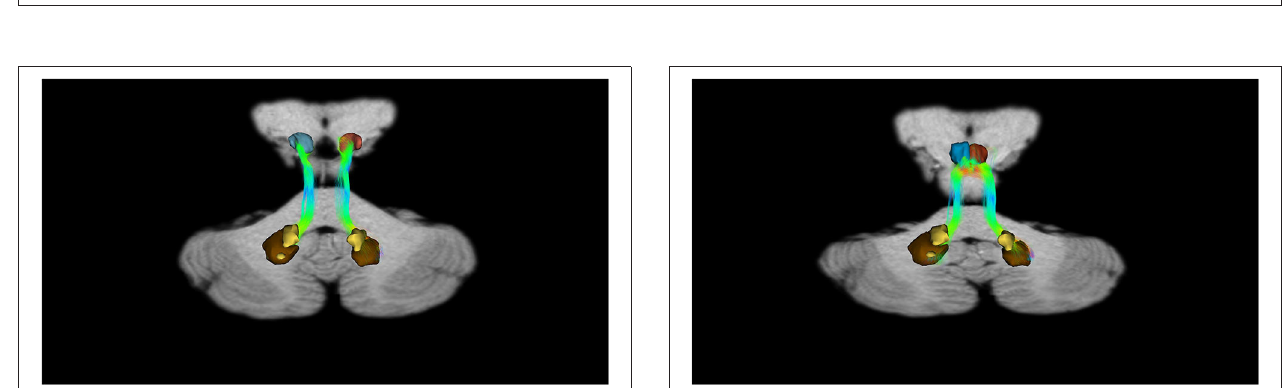
FIGURE 5 | Structural connectivity of SNpc and VTA, including putative midbrain-cerebellar connectivity. Data were obtained from the 100-unrelated-subjects sample of the HCP repository (see Van Essen et al., 2013) Diffusion datasets were processed using a multi-shell, multi-tissue constrained spherical deconvolution (MSMT-CSD) algorithm (see Jeurissen et al., 2014). A number of 10,000 streamlines passing through the left SNpc (dark red) and VTA (light red) regions of interest (see Pauli et al., 2018) (A) was generated. Streamlines were mapped to structural scans, transformed to MNI152 standard space, binarized, and summed up to obtain tract maximum probability maps (MPMs). A threshold of 50% was applied to show only tracts overlapping in at least half of the sample (B) . Tractography was run on 30 high-quality 3T structural and diffusion data from the Human Connectome Project (HCP). Data were downloaded in a minimally pre-processed form and elaborated using the signal processing technique known as Constrained Spherical Deconvolution (CSD). Regions of interest (ROI) were delineated by means of multi-atlas automated segmentation: Substantia nigra (SN) and Ventro Tegmental Area (VTA) were resliced into subject space from Adcock’s probabilistic atlas; dentate nucleus (both dorsal and ventral part) using the deep cerebellar nuclei atlas featured in SPM Anatomy Tract colors are attributed according to the spatial orientation of streamlines: superior-inferior (blue), anterior-posterior (green), and latero-lateral (red).